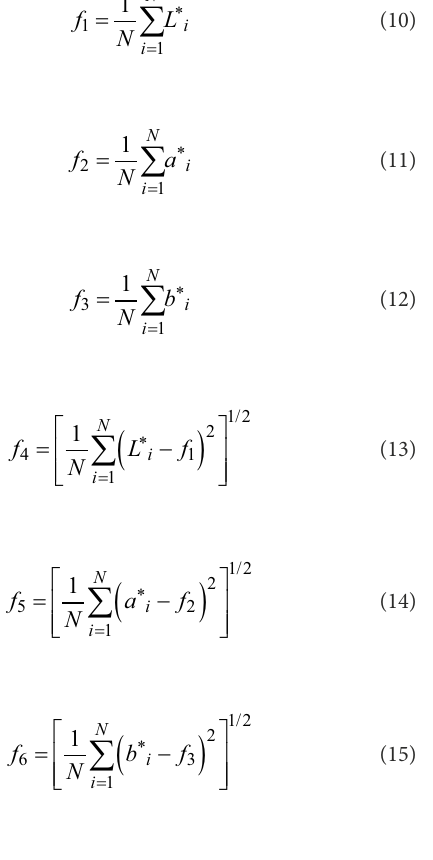
TABLE 1 Sixteen-dimensional multi-color physical features.